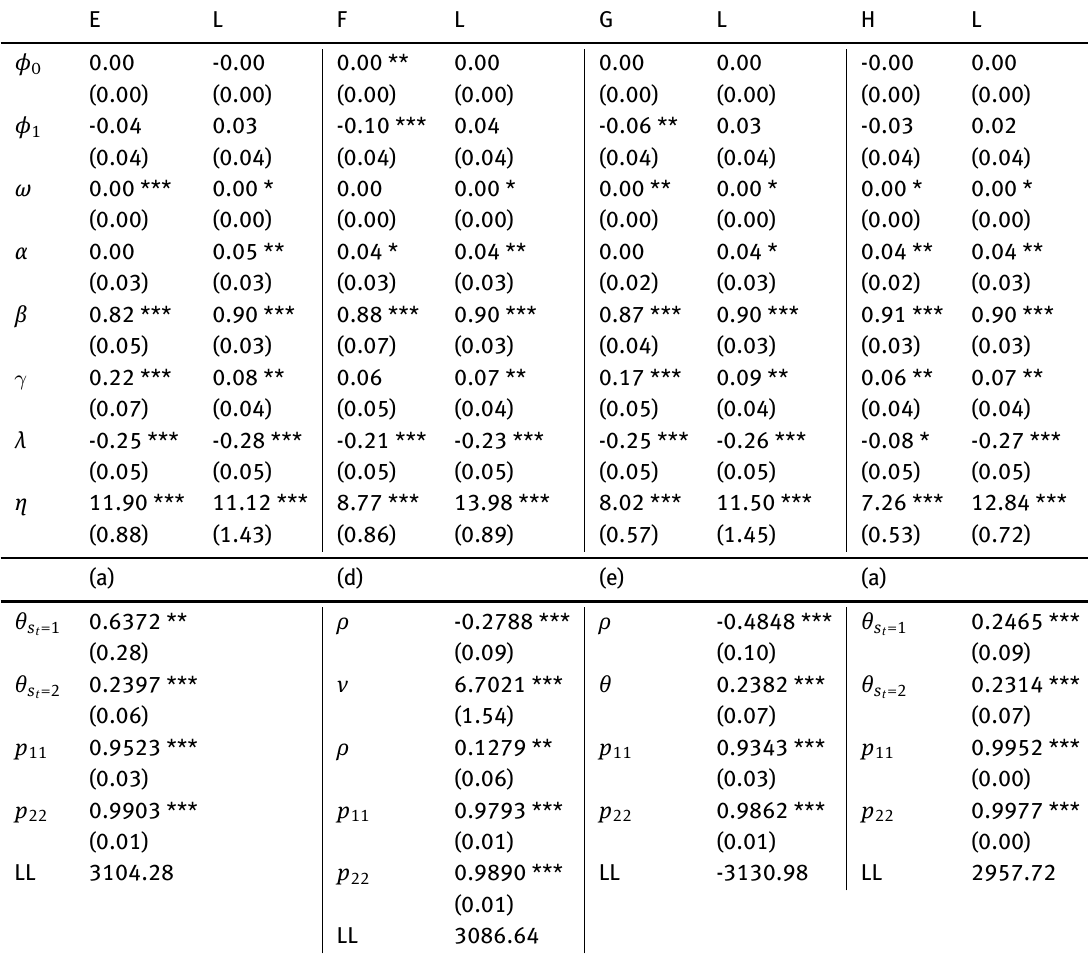
Table 8b: Parameter estimates for the joint distribution using a mixture of copulas where the weights are given by the forecast probability of each